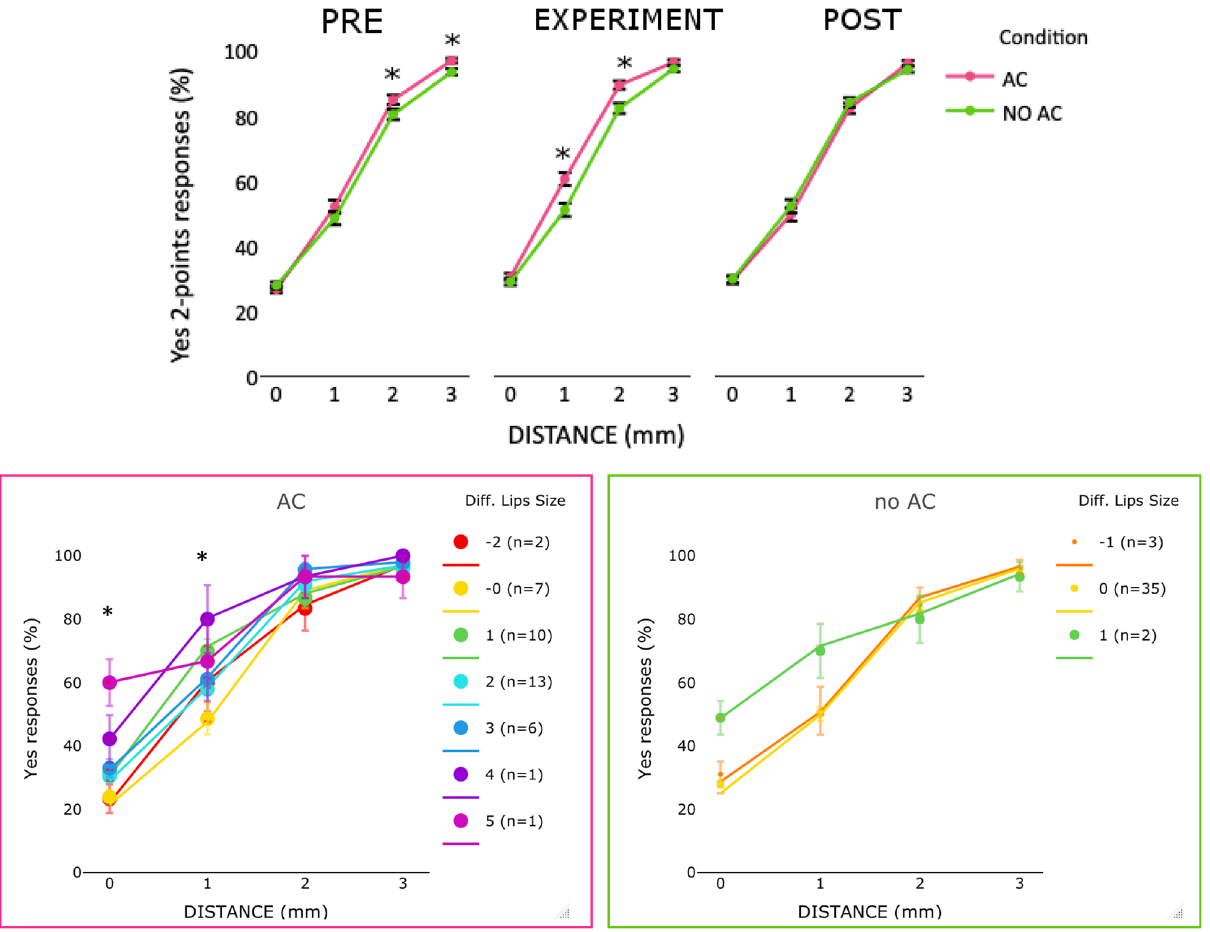
Figure 4. Top panel, mean (markers) and SE of the means (error bars) of yes responses in 2PD in PRE, EXPERIMENT and POST conditions for AC and no AC conditions at each distance (0, 1, 2, 3 mm) in Experiment 2. Bottom panel, mean (markers) and SE of the means (error bars) of y es responses in 2PD in AC (left panel) and no AC (right panel) conditions as a function of the distance (0, 1, 2, 3 mm) between 2 stimulation sites and the change in the perceived lip size (lips only rating) in Experiment 2. The legend describes the amount of perceived change in the lip size and the number of individuals who perceived that change. Negative numbers indicate a perceived decrease and positive numbers indicate an increase in the perceived lip size compared to PRE. In the bottom row plots, colored lines represent the estimated effects in